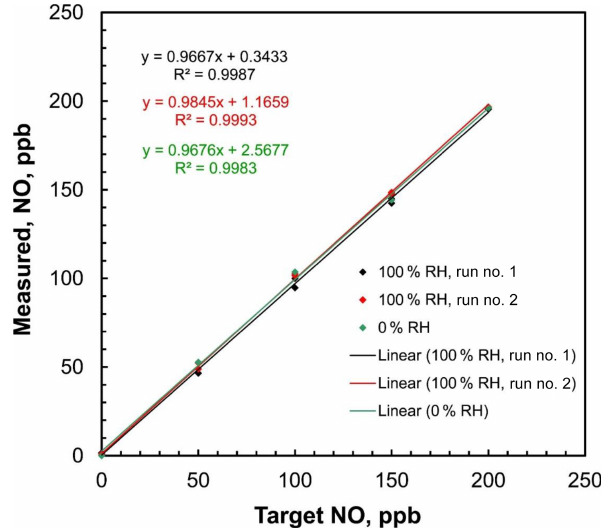
Figure 8. Linear regressions of measured NO concentrations vs. tar- get concentrations of the 2B Technologies Model 408 NO Calibra- tion Source with dilution air containing both 0% and 100% relative humidity at 23.5 ◦